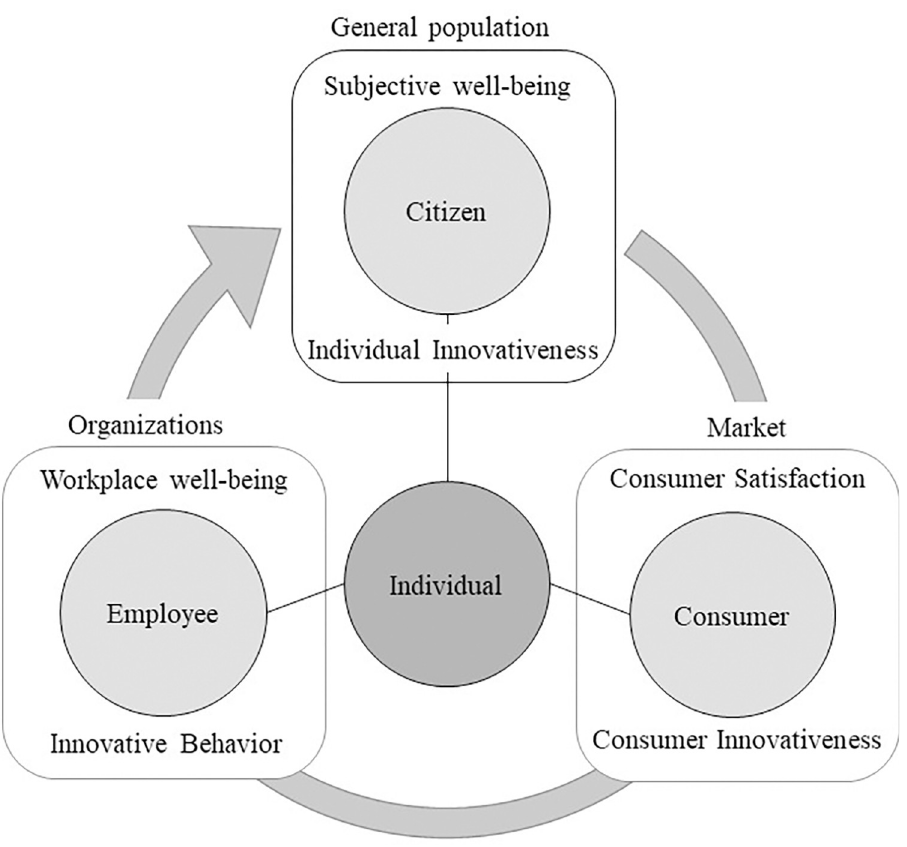
Fig 5. Abstraction showing contextual well-being and innovativeness constructs for an